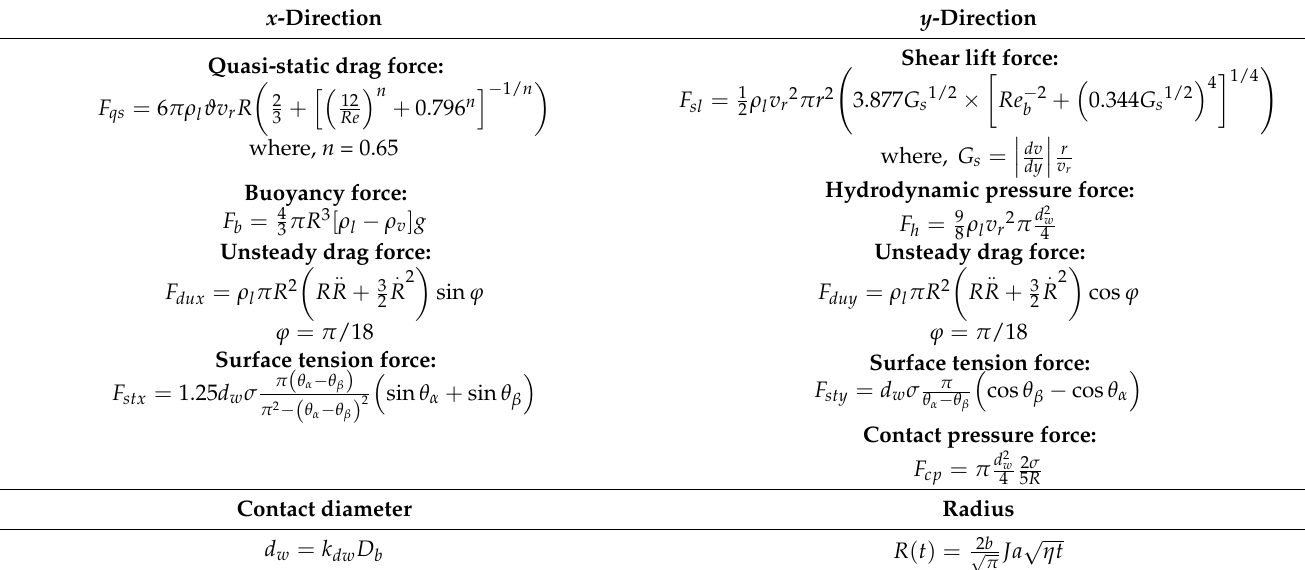
Table 1. Summary of forces for determining bubble departure diameters and